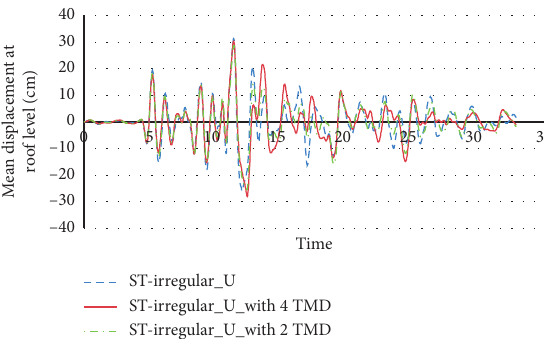
Figure 24: Displacement of the ten-story irregular U-shaped model with 2 and 4